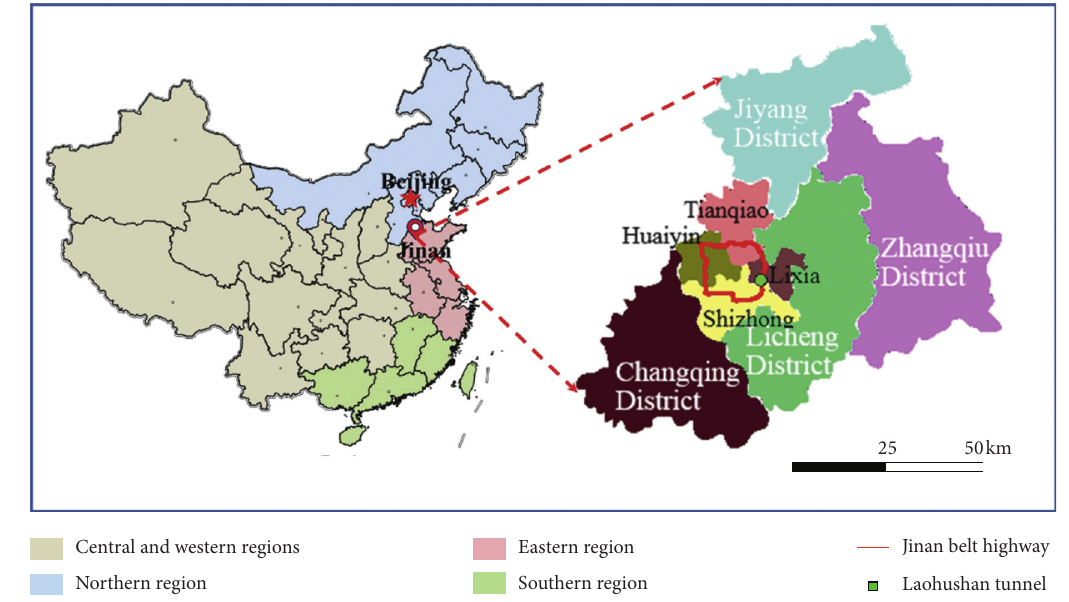
Figure 1: Geographical location of Laohushan tunnel in China. Table 1: Support parameters of